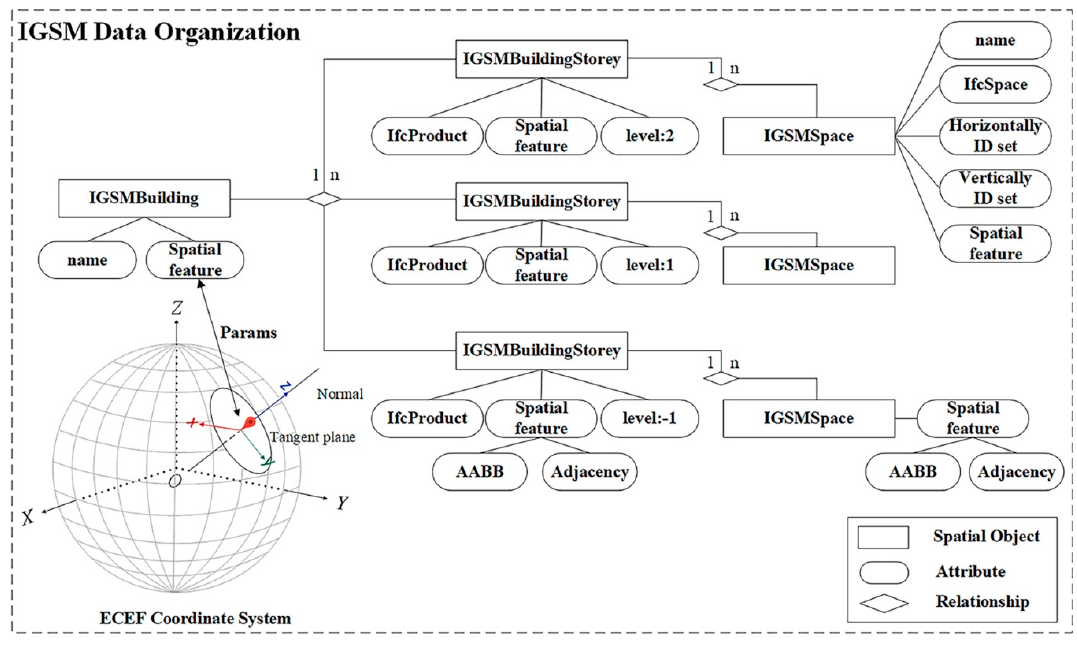
Figure 4. IGSM Data Organization. Figure 4. IGSM Data